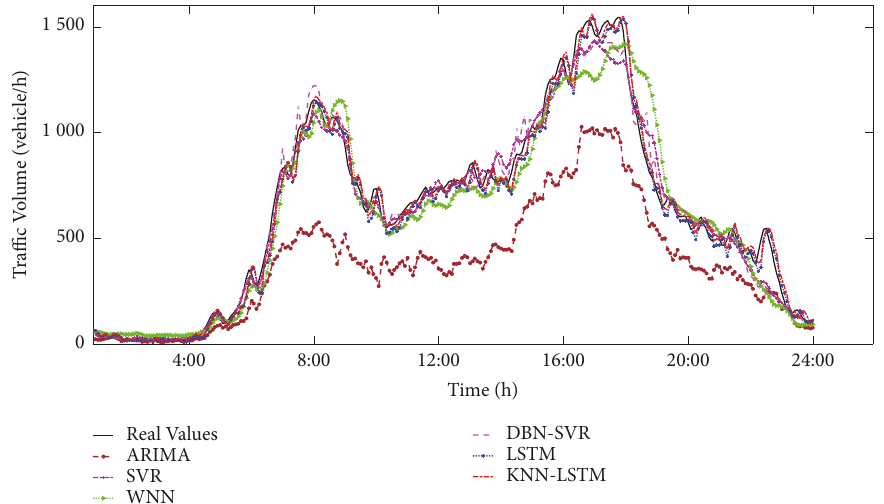
Figure 6: The real and predicted traffic flow in S339.